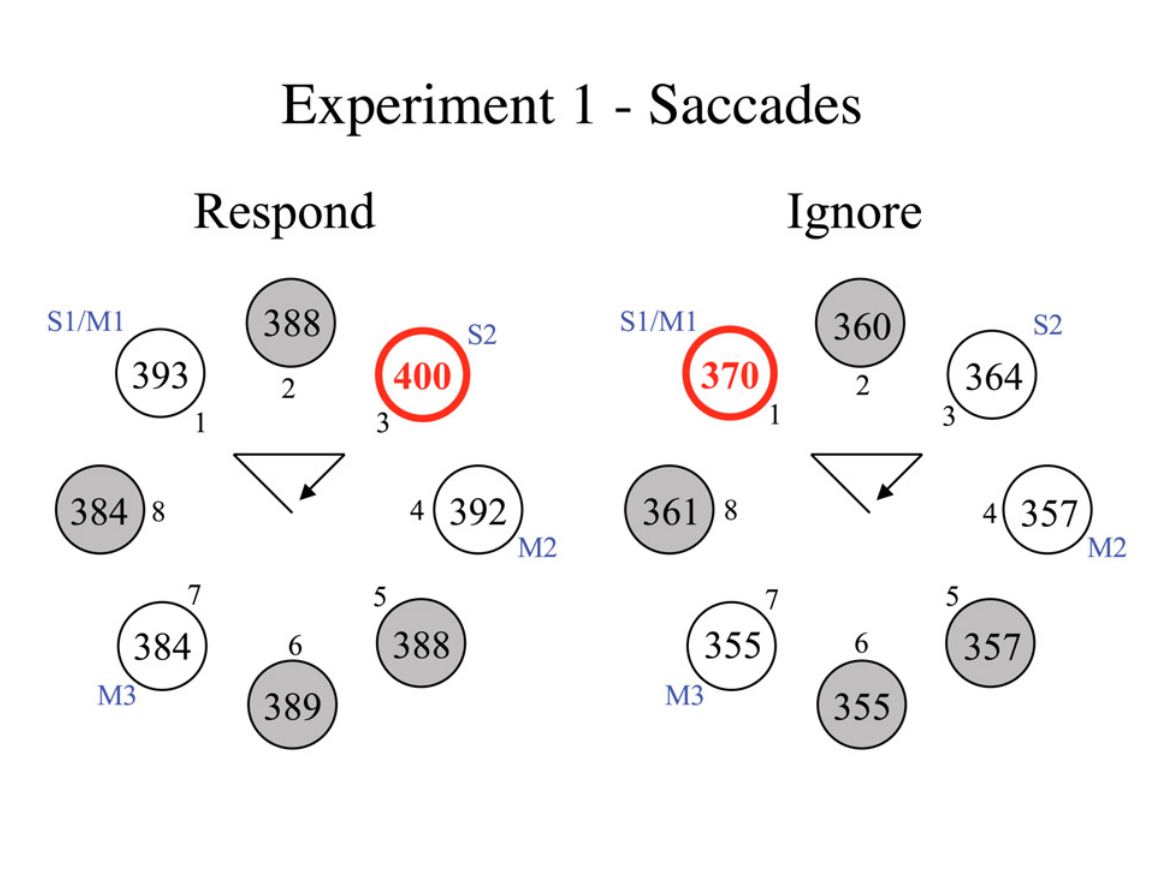
FIGURE 4. Mean of median saccadic RT in the Respond and Ignore conditions of Experiment 1. The mean RTs to targets occurring in each of the 8 positions are given. The arrow schematically illustrates the sequence of cues (position 1, then 3, then fixation). The shaded circles are the neutral locations. Significantly inhibited locations are indicated in